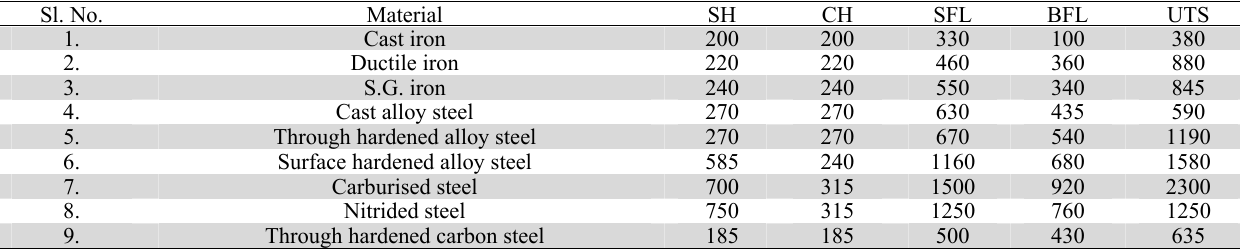
Decision matrix for gear material selection problem (Milani et al., 2005) Sl. No.